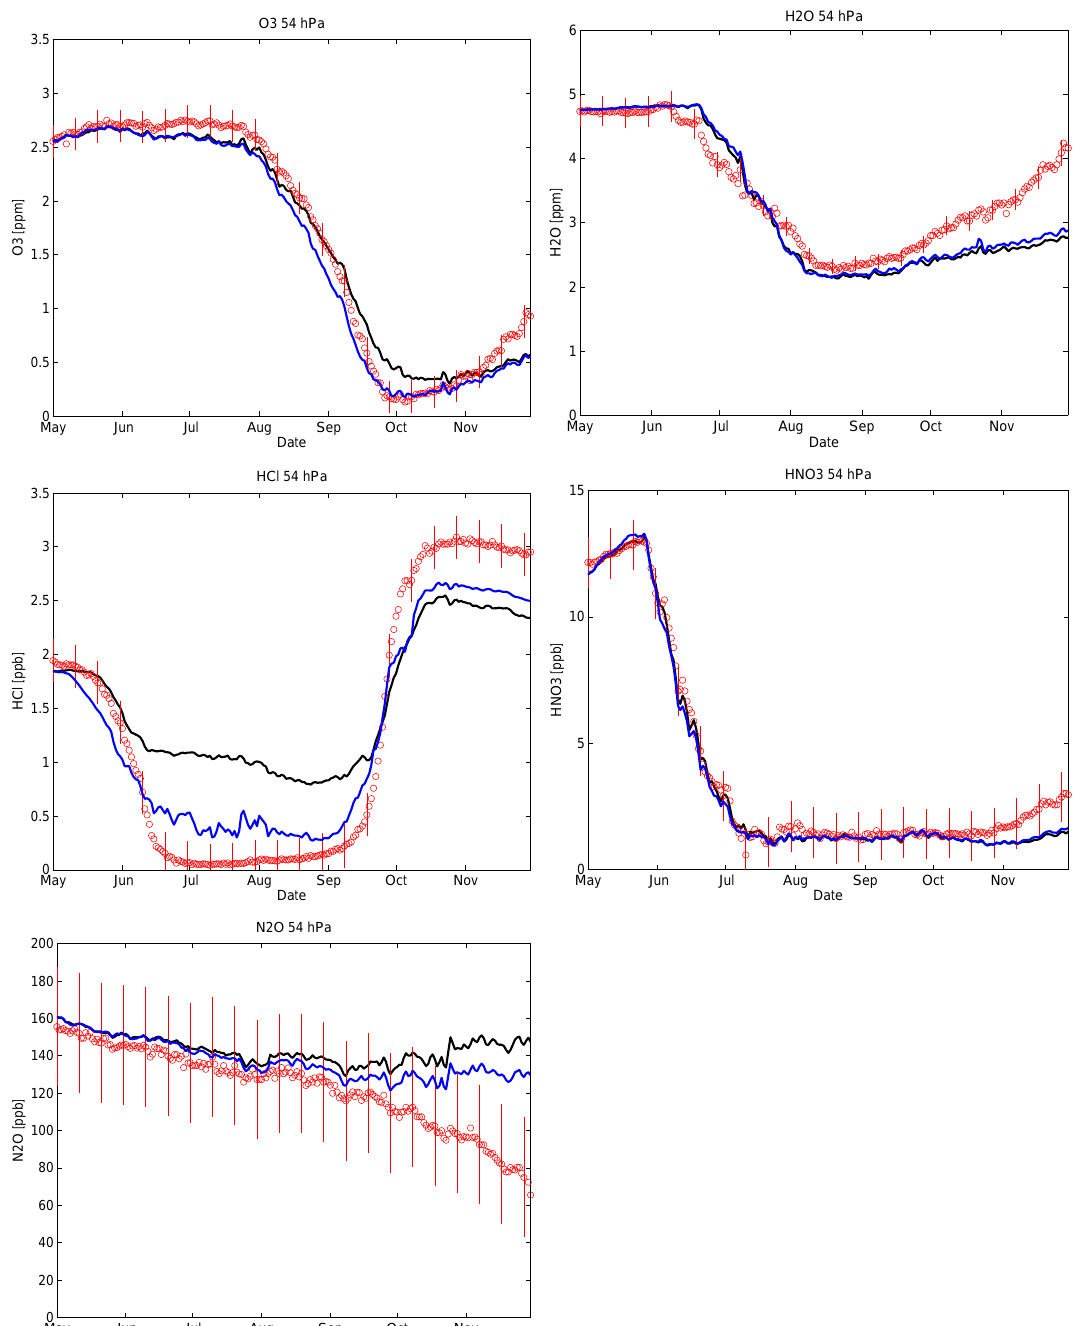
Figure 22. Comparison of vortex-averaged mixing ratios for the Antarctic winter 2006.